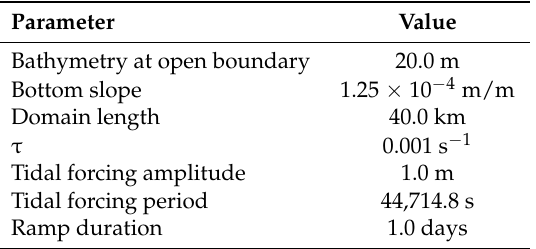
Table 1. Parameters for the linear sloping domain test